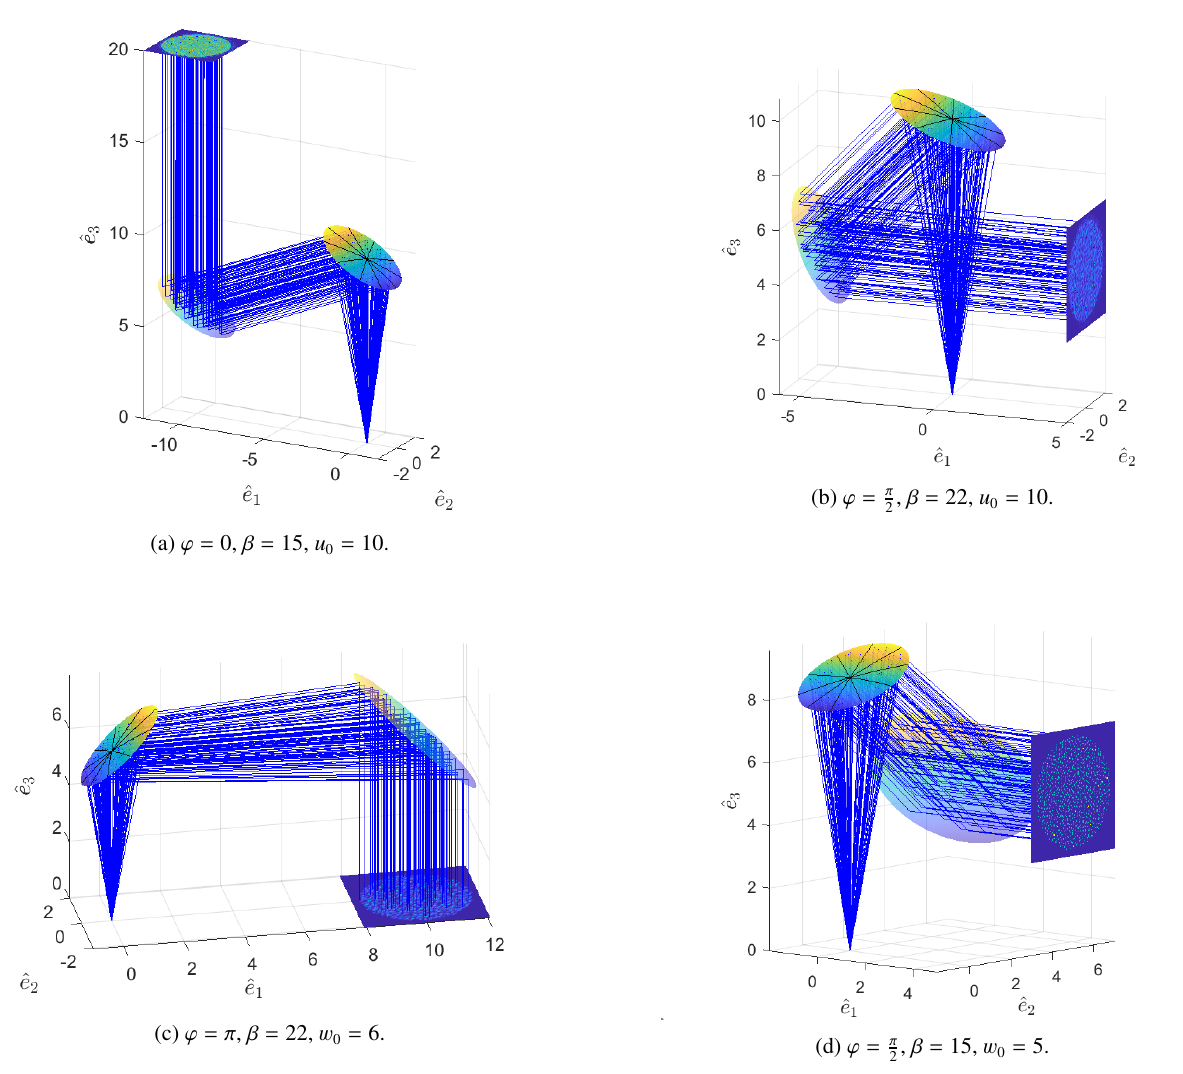
Figure 2: Some examples of layouts constructed with our algorithm having a uniform source and target distribution.